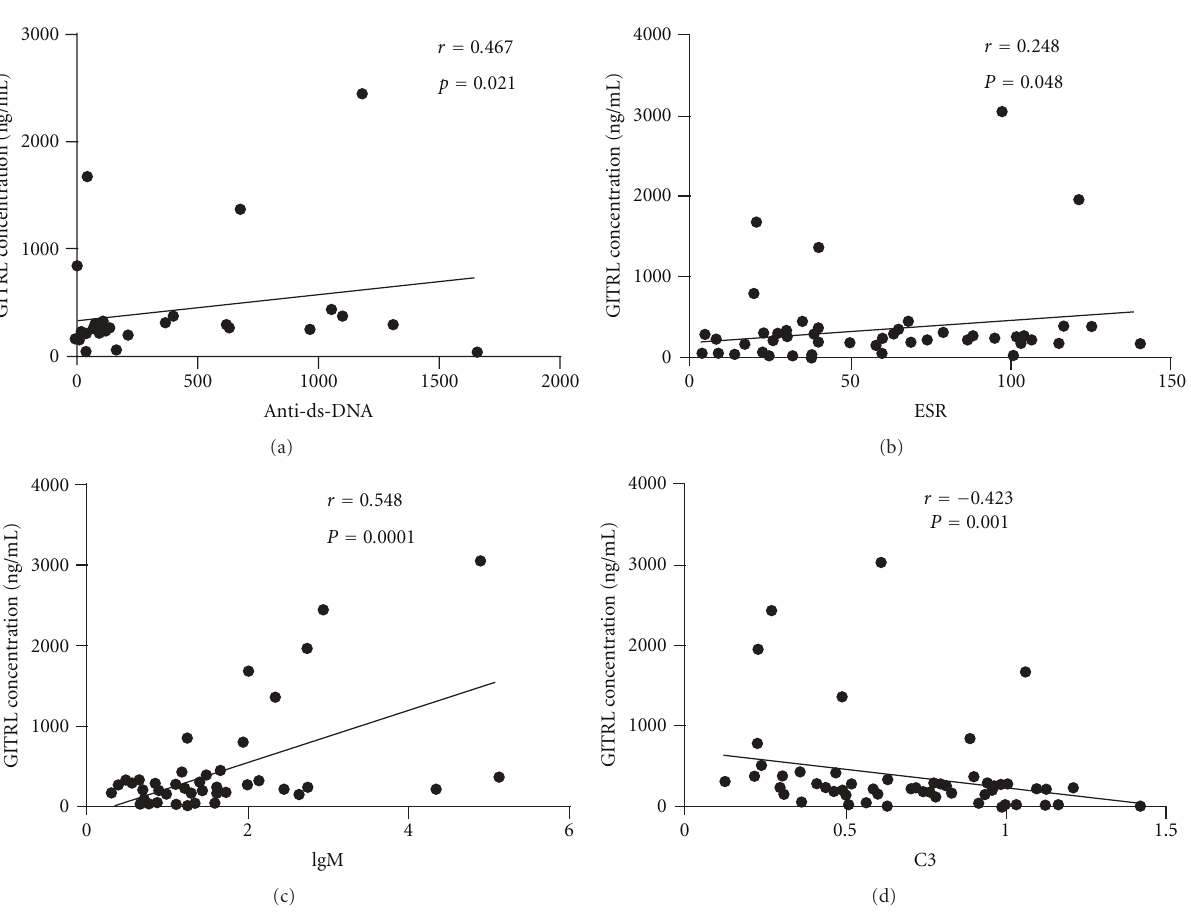
Figure 3: Correlation of serum GITRL levels with laboratory values. Each symbol represents an individual patient. (a) Positive correlation was observed between serum GITRL levels and the titers of antidsDNA antibody. (b) Positive correlation was also seen between serum GITRL levels and ESR. (c) Positive correlation was also observed between serum GITRL levels and IgM. (d) Negative relationship was observed between serum GITRL levels and C3. Anti-dsDNA antibody, antidouble stranded DNA antibody. C3: complement 3; ESR: erythrocyte sedimentation rate; IgM: immunoglobulin